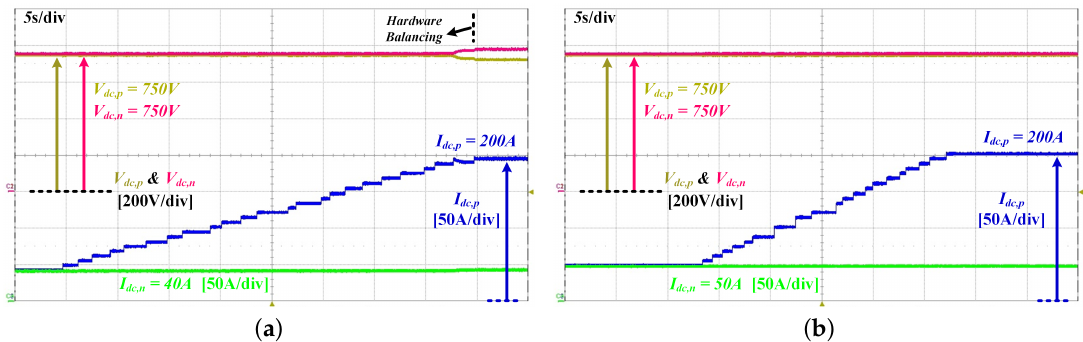
Figure 16. Experimental results of the boundary of balanced DC-link voltage using